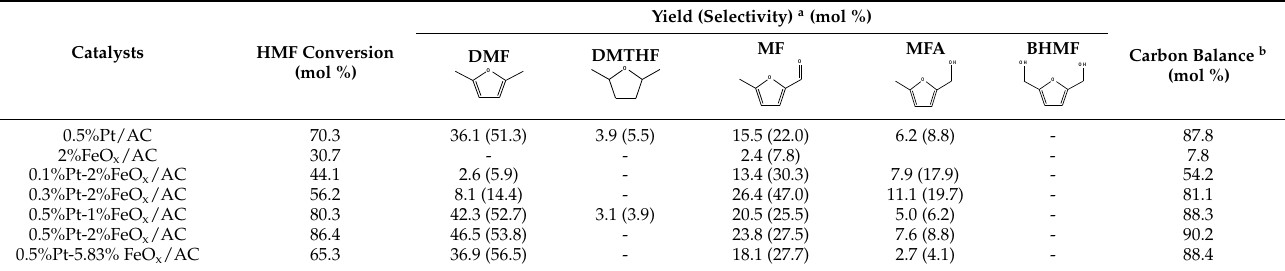
Table 2. HMF hydrogenolysis to DMF over different catalysts.